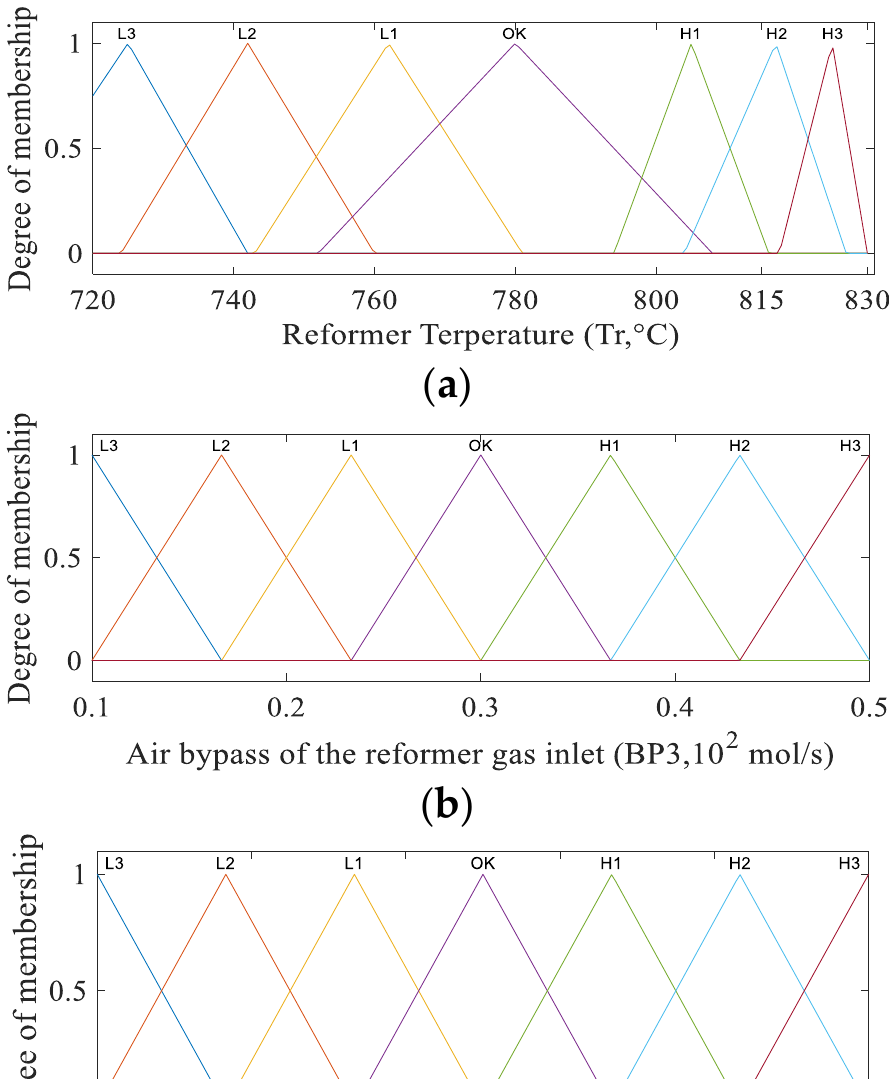
Figure 3. Membership function: ( a ) Tr; ( b ) BP 3 ; ( c )